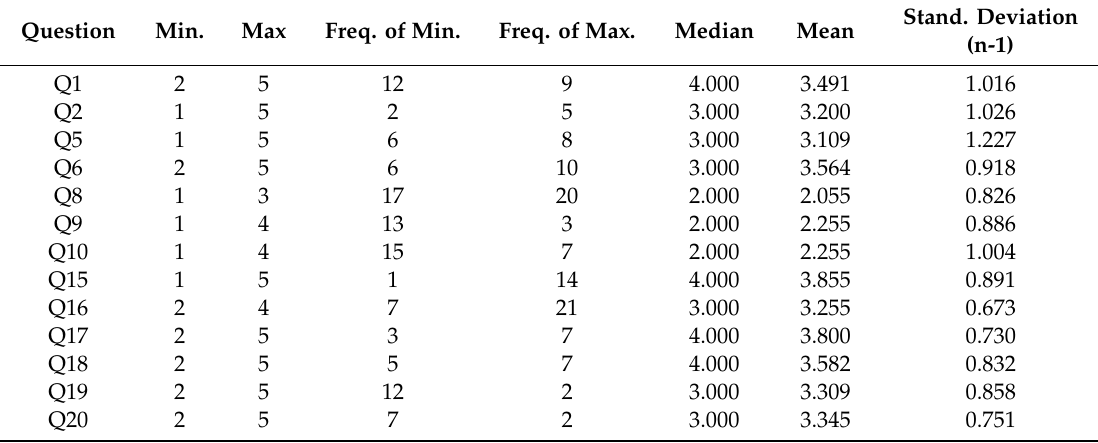
Table 2. Phase 2: Descriptive statistics of the students’ views regarding